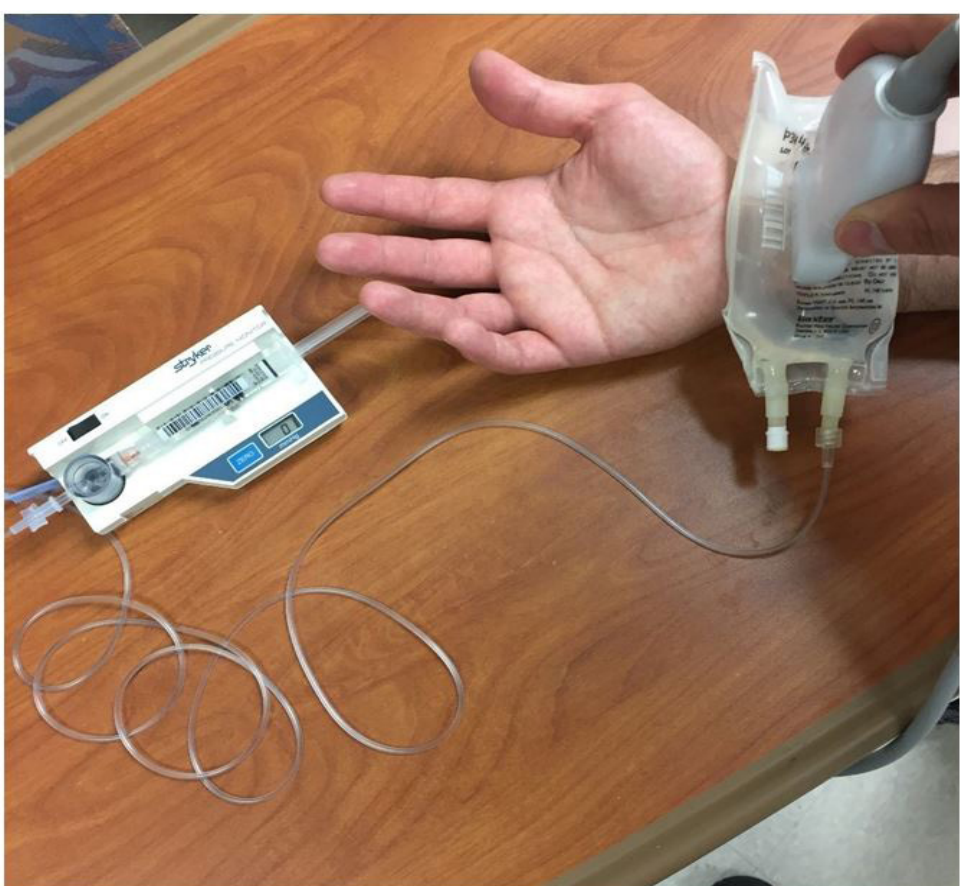
Figure 3. Radial artery is visualized through 100mL bag of normal saline with ultrasound probe and compression is applied to achieve coaptation and complete collapse of the artery